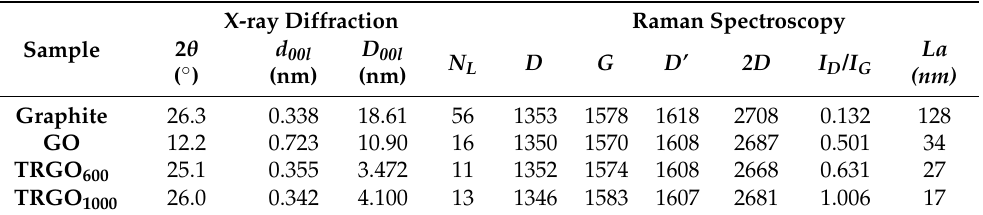
Table 2. Structural features of graphite, GO, TRGO 600 , and TRGO 1000 determined by X-ray diffraction and Raman spectroscopy.